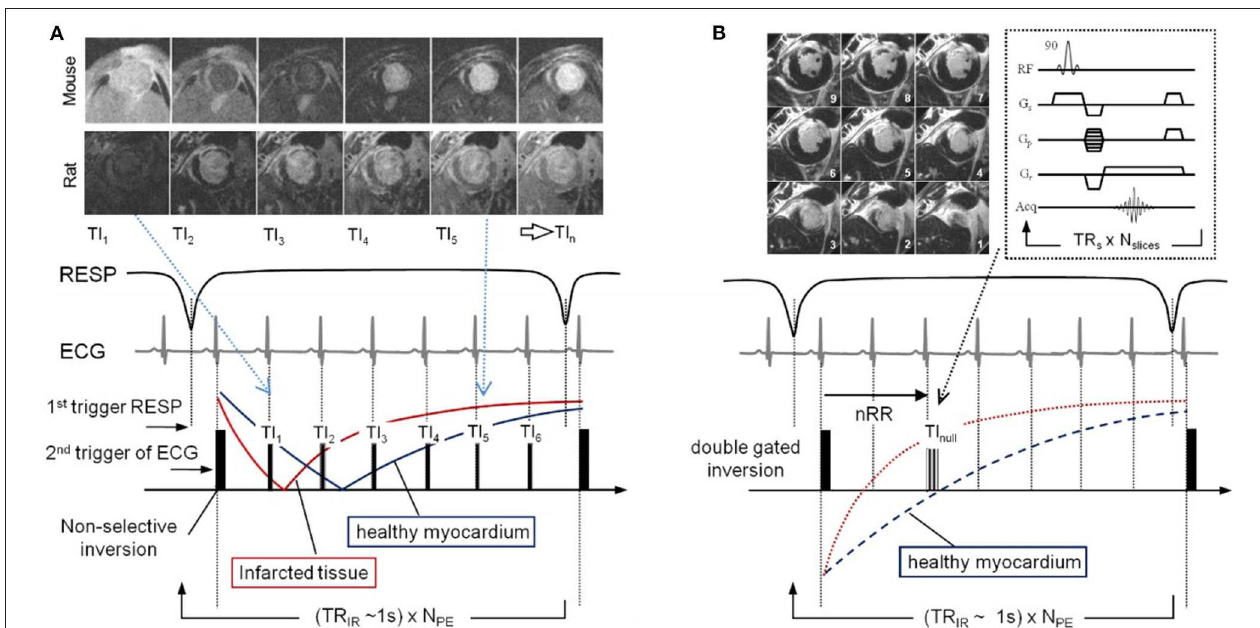
FIGURE 10 | Pulse sequence diagrams for LGE imaging. (A) Look-Locker pulse sequence and gating strategy used to acquire multiple inversion time (TI). Images from TI1–TI6 time points are shown for both mouse and rat, where the indices are related to the number of R-wave triggers given the double gated inversion pulse. (B) The LGE IR sequence diagram follows the same gating and acquisition scheme but acquires a 90 ◦ flip angle multislice GRE stack at the nearest TI value to null healthy myocardium. TR s is the time between slice acquisition pulses, TR IR is the time between inversion pulses, N PE is the number of phase-encoding steps, and N slices is the number of slices. Reproduced with permission from Price et al. [177].